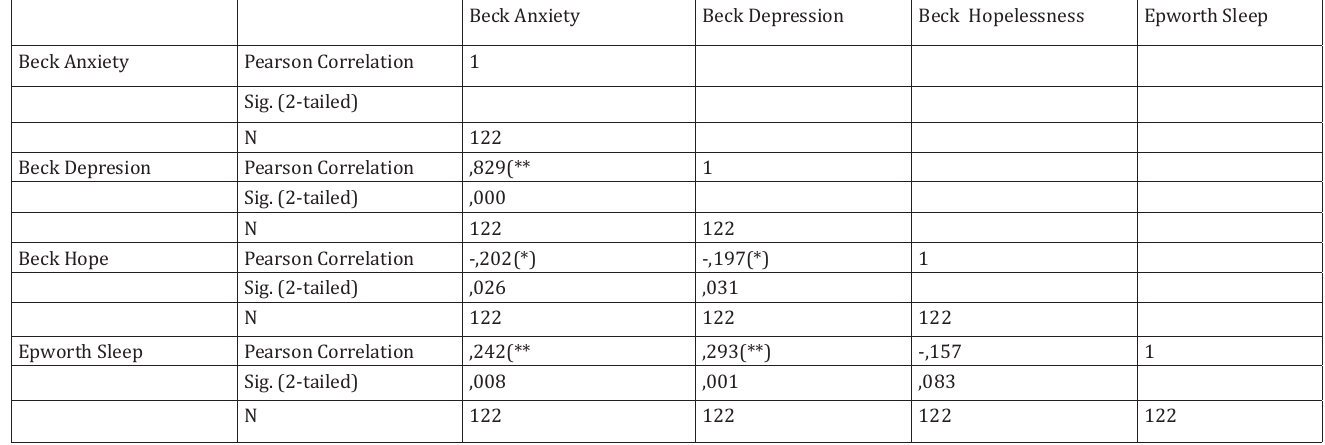
Table 3 Correlation Analysis of the Scales